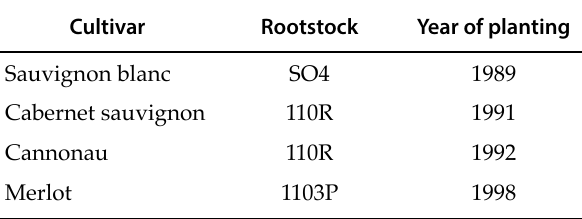
Table 1. Characteristics of the assessed